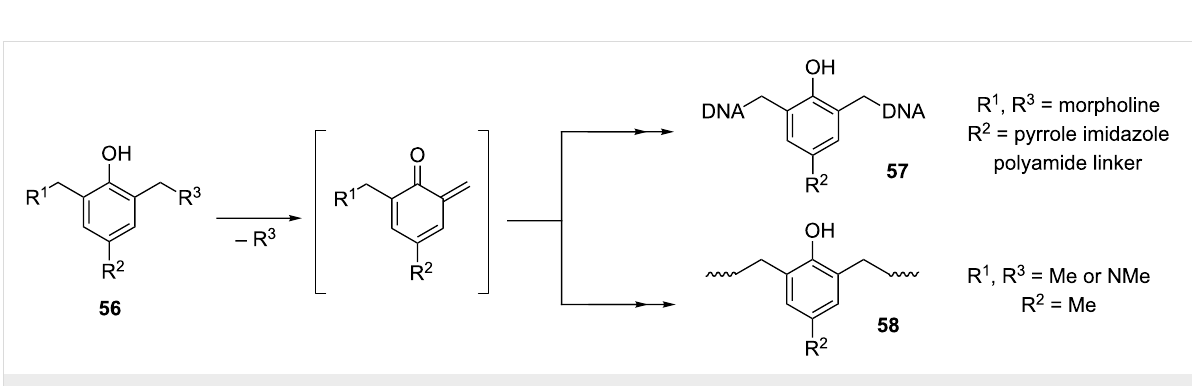
Scheme 9: Formation of DNA linkers and o -QM mediated